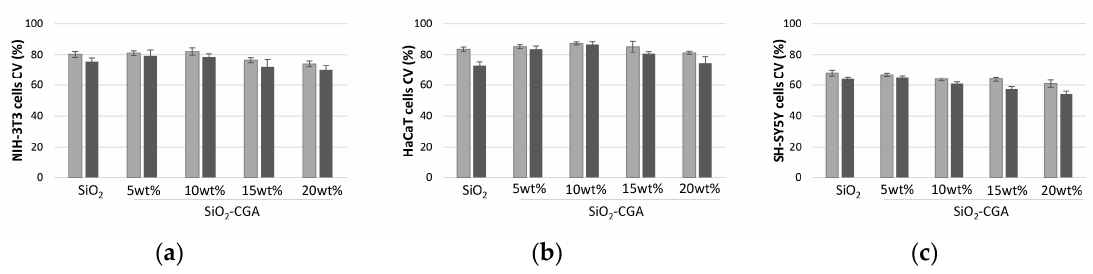
Figure 8. Cell Viability (CV, %) of ( a ) NIH-3T3, ( b ) HaCaT, and ( c ) SH-SY5Y cells treated with ■ 1.0 mg, and ■ 2.0 mg of SiO 2 -CGA hybrids, after 48 h exposure time by means of MTT test results. Values, reported as percentage vs. an untreated control, are the mean ± SD of measurements carried out on three samples ( n = 3) analyzed six times.